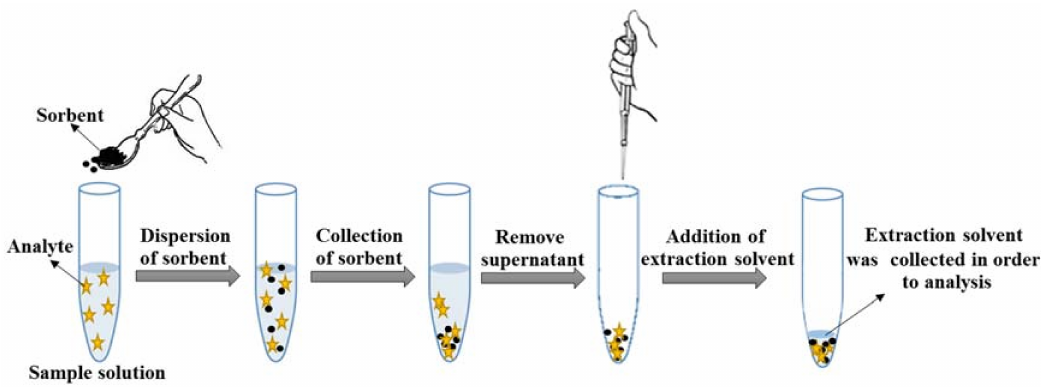
Figure 8. Schematic diagram of the proposed extraction